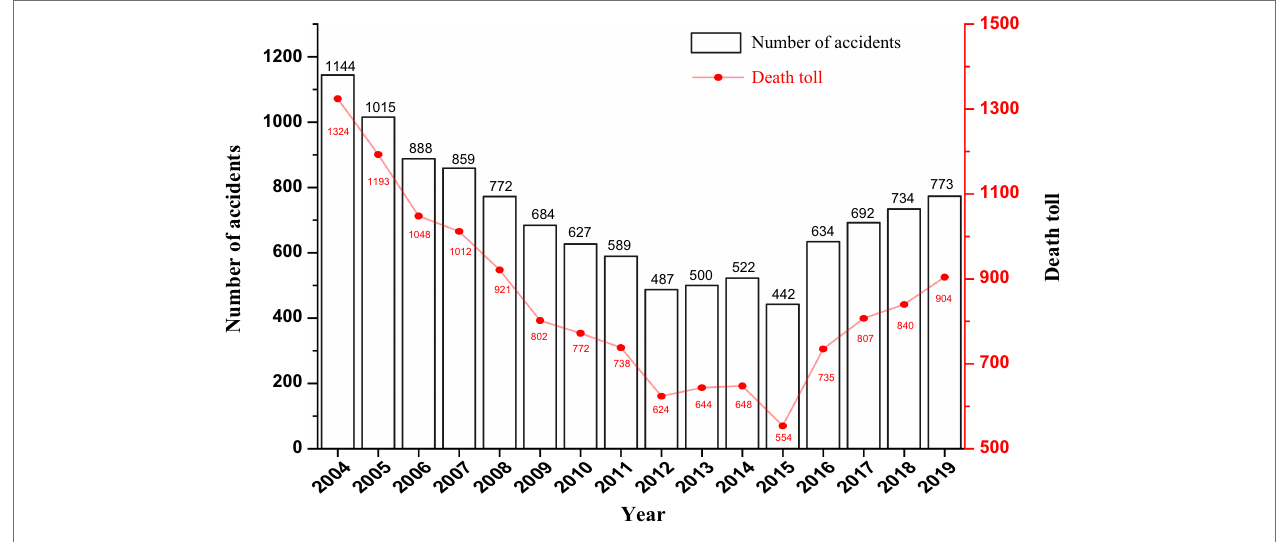
FIGURE 1 | Distribution by number of Safety accident in construction from 2004 to